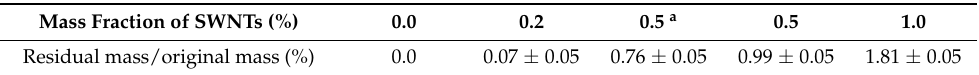
Table 6. Mass fractions of residues normalized by the original sample mass collected after gasification tests. Reprinted with permission from Ref. [161]. Copyright 2005, Elsevier.